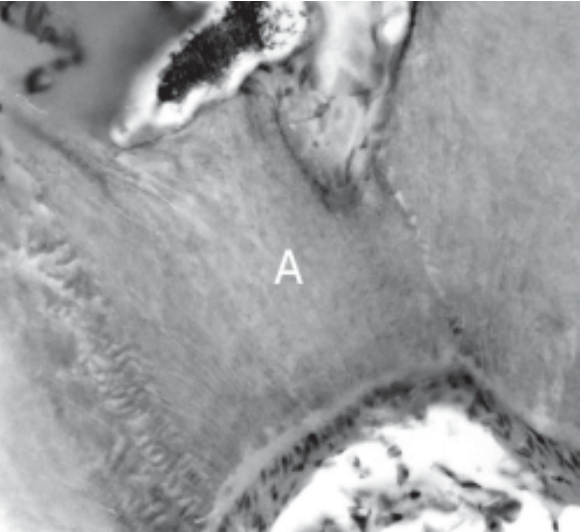
FIGURE 3 - White Portland cement (120 days). H.E. 40 X. (A) Dentin bridge